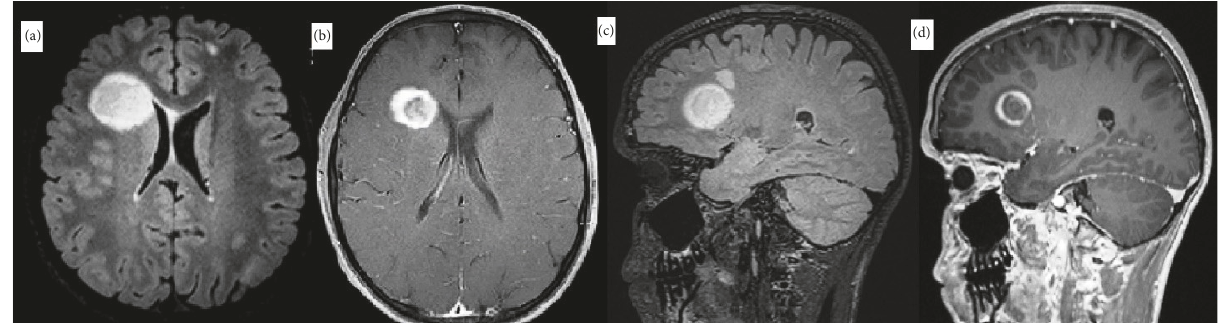
Figure 2: One month later. ((a),(c)) Improvement of the tumefactive lesion is visible in the left frontal lobe and a new tumefactive lesion has appeared in the right frontal white matter. ((b),(d)) T1-weighted postcontrast images show ring